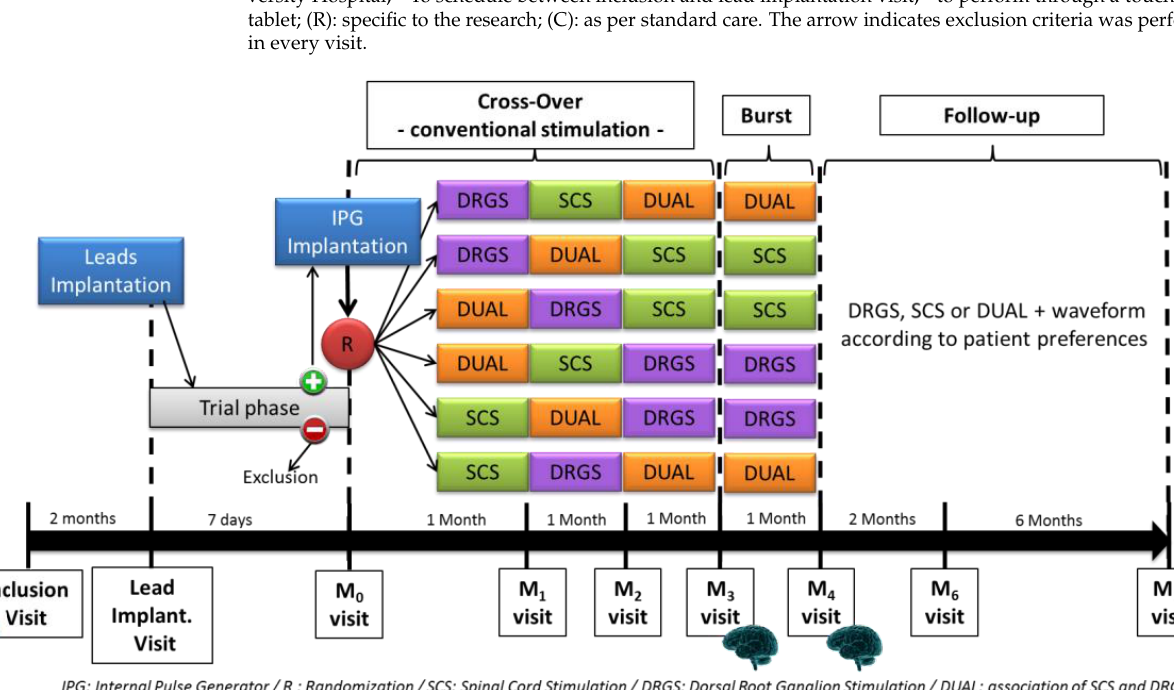
Table 1. Radio-clinical assessment calendar.